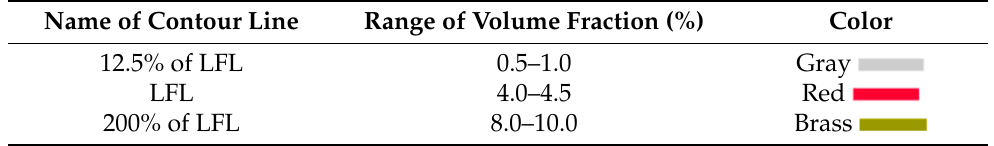
Table 3. Colors assigned for each range of volume fraction of hydrogen.